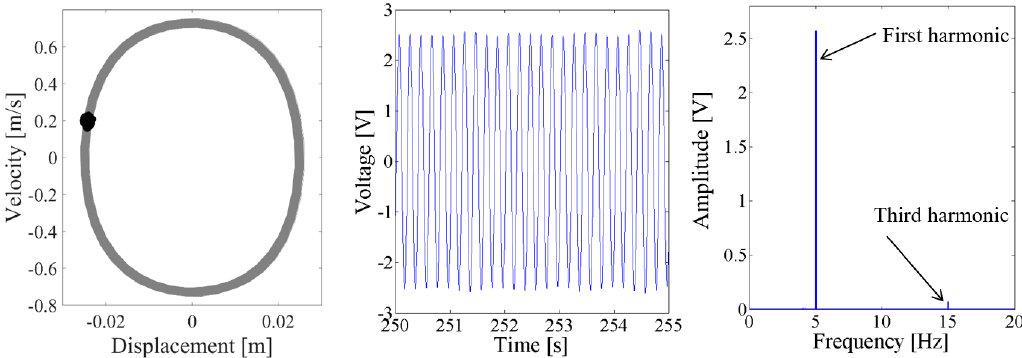
Figure 17. Dynamic responses of the coupled harvester-2 for the excitation level of 0.6 g.